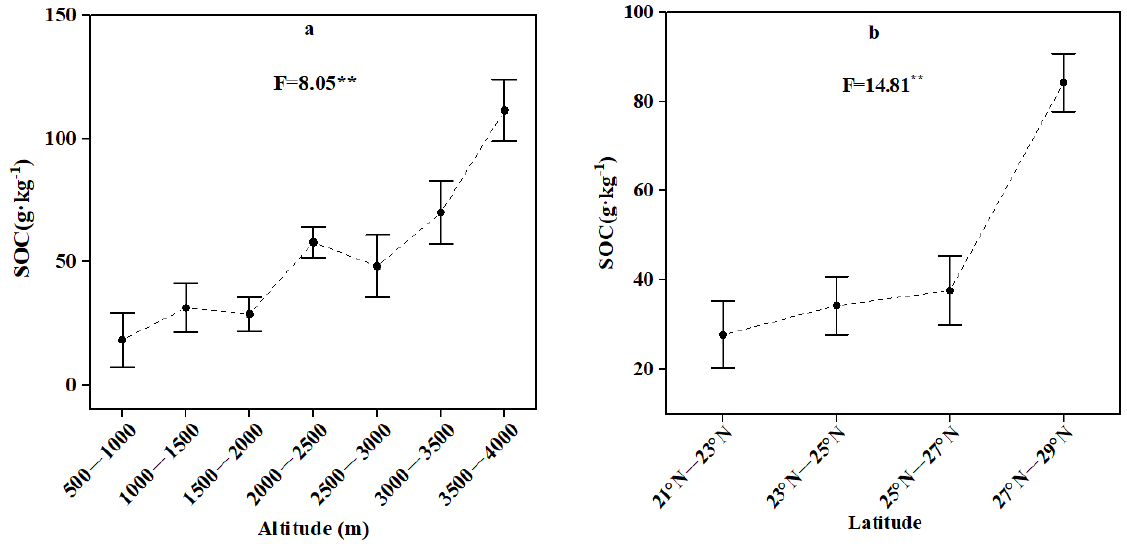
Figure 2. Variation of forest soil organic carbon with altitude ( a ) and latitude ( b ) ** p < 0.01.